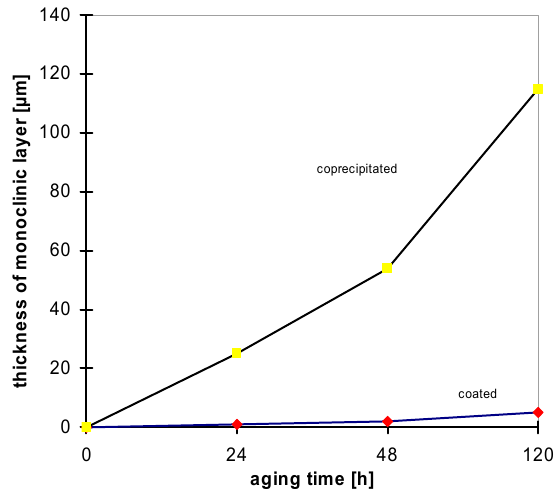
Figure 20. Thickness of the corroded layer after hydrothermal treatment.